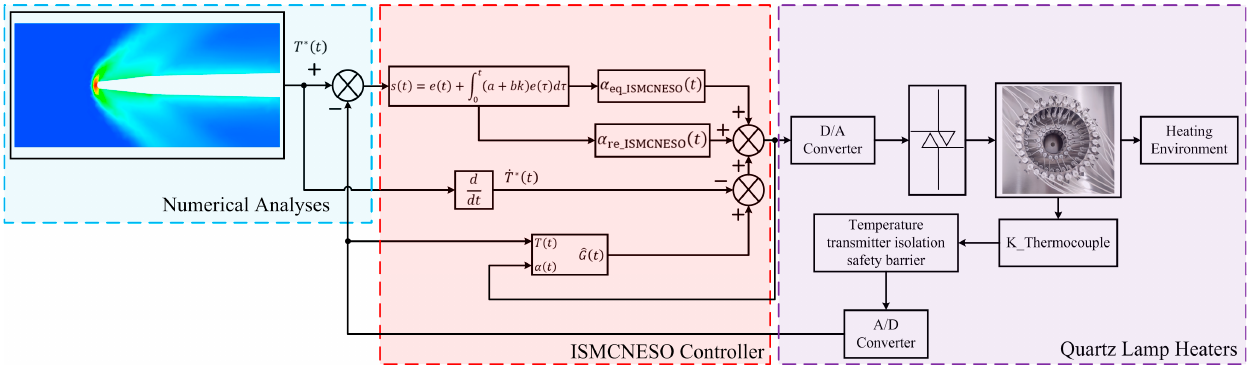
Figure 11. Schematic illustration for the ISMCNESO controller.